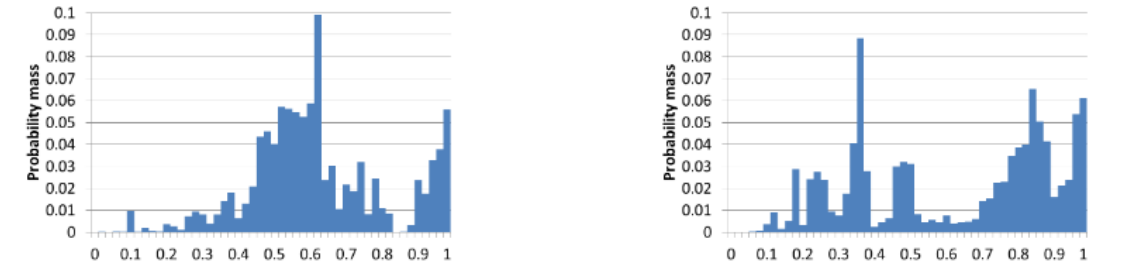
Figure 3. Earth-mover’s distance has proven a successful metric for distance between probability